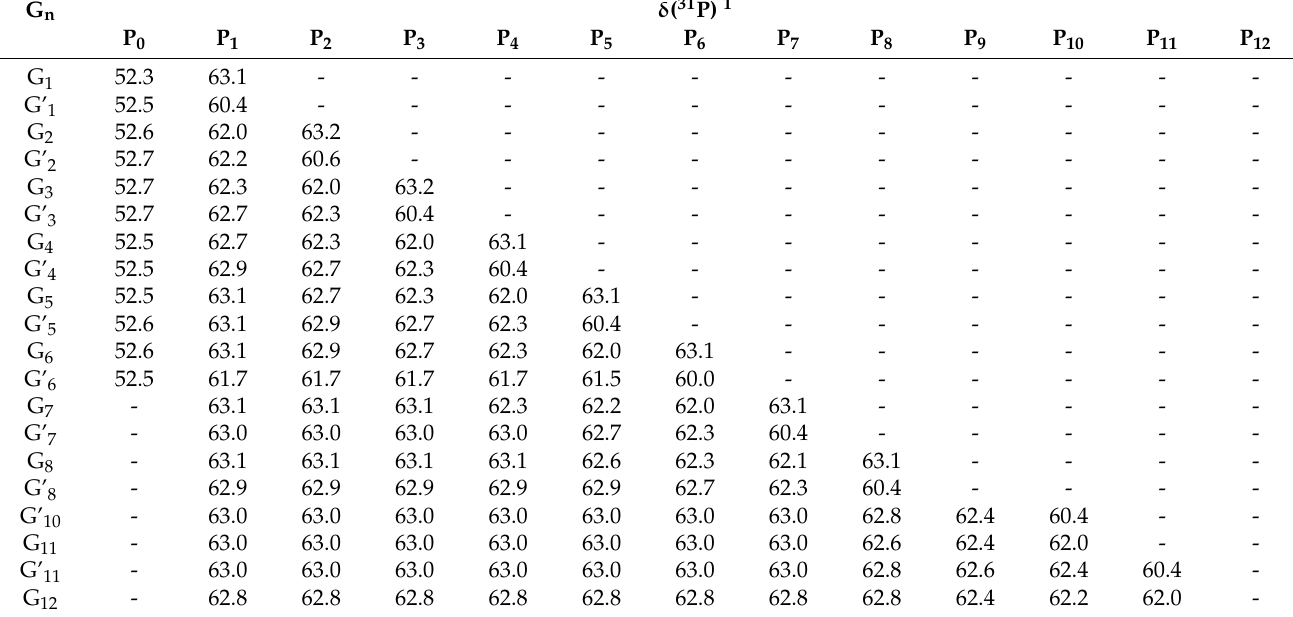
Table 2. 31 P NMR chemical shifts of phosphorus-containing